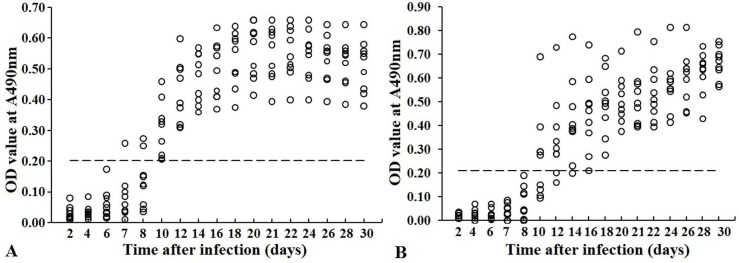
Kinetics of serum anti-Trichinella IgG in mice experimentally infected with 300 muscle larvae.Anti-Trichinella IgG was detected by rTsSP-ELISA (A) and ES-ELISA (B). The cut-off value is represented by the dotted line.